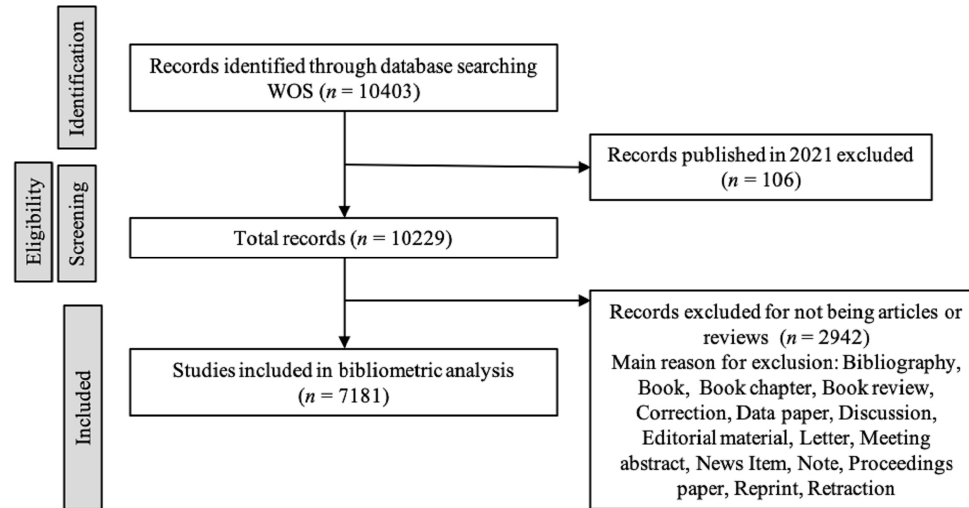
Figure 1. Flow chart of information of the retrieval strategy of articles on POP.